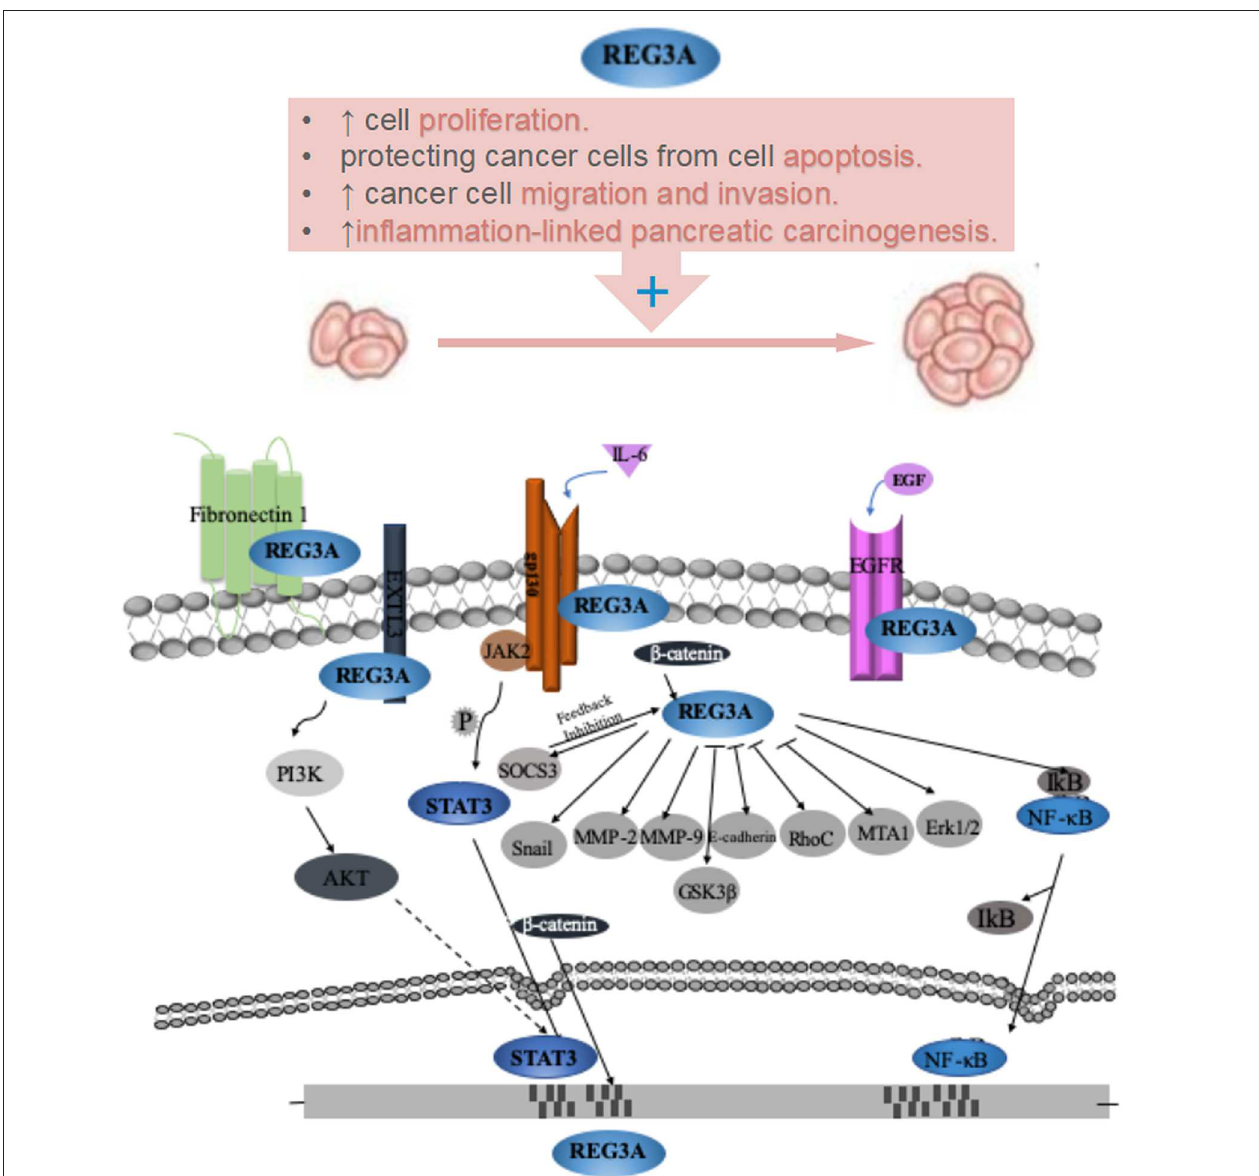
FIGURE 1 | Role and its underlying mechanisms of Reg3A for carcinogenesis of gastrointestinal